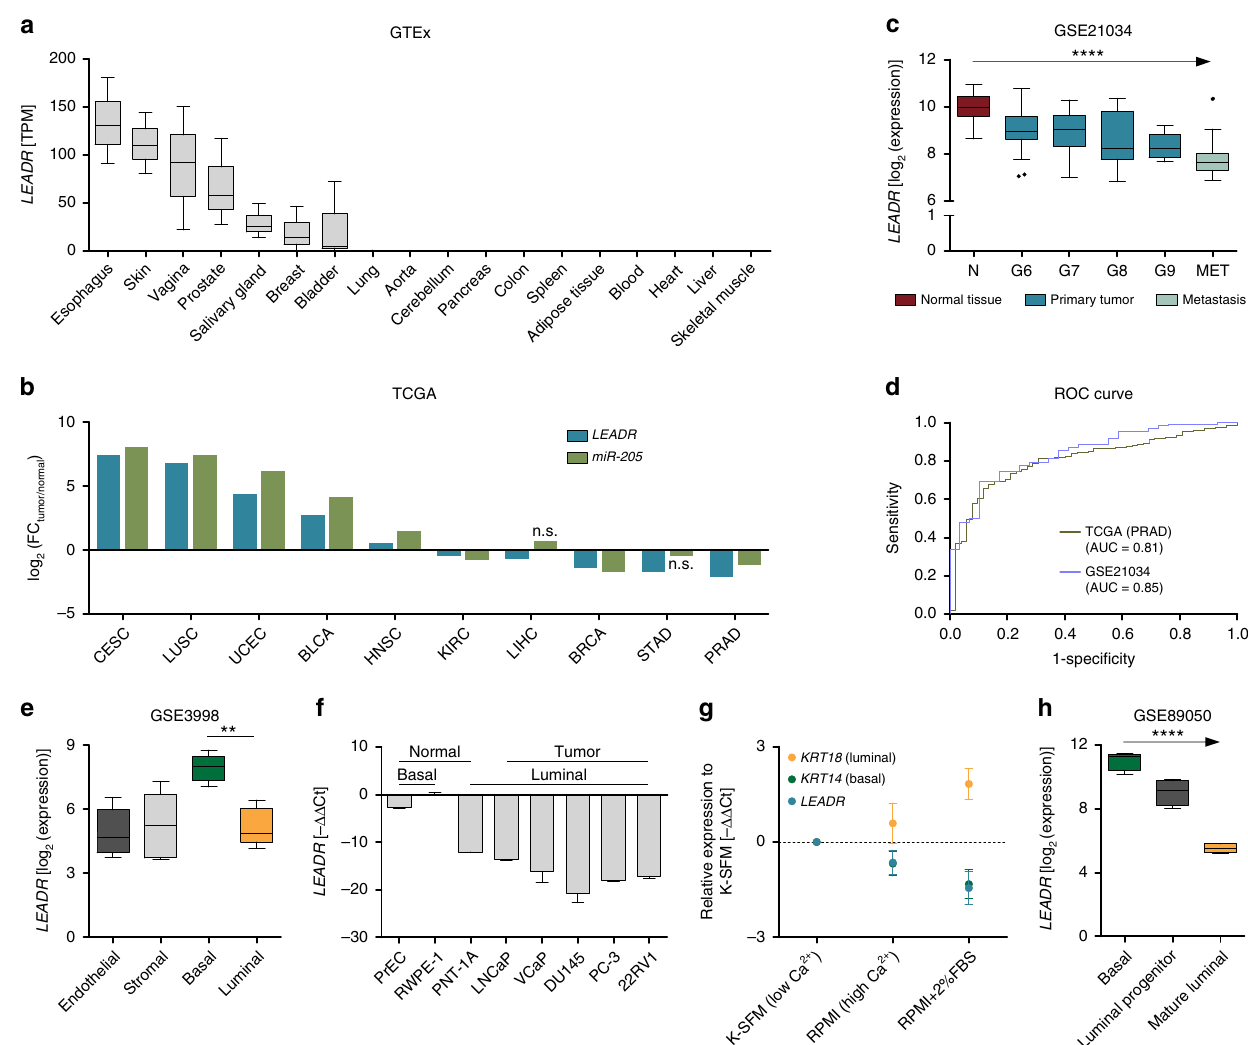
Fig. 1 LEADR/MIR205HG expression is enriched in prostate basal cells and reduced upon luminal differentiation. a Tukey ’ s box plot of LEADR/MIR205HG expression in human tissues as retrieved from GTEx data portal. b Bar plot of LEADR/MIR205HG and miR-205 fold-change (FC) in tumor vs. normal samples from TCGA. Only tumors where LEADR/MIR205HG is signi fi cantly differentially expressed compared to normal counterpart are shown (Student ’ s t test, p value threshold 0.05). Note that for all tumors where LEADR/MIR205HG is differentially expressed, also miR-205 is differentially expressed and in the same direction, except for LIHC and STAD, where the difference is not signi fi cant (n.s.). All tumor/normal pairs together with acronym meaning are reported in Supplementary Fig. 2a. c Tukey ’ s box plot of LEADR/MIR205HG expression in normal and tumor prostate samples from GSE21034 dataset. Jonckheere – Terpstra test evidences a signi fi cant decreasing trend along tumor progression. Samples are classi fi ed as normal (N), primary tumors (ranked based on Gleason pattern score grading system from G6 to G9), and metastatic (MET). d ROC curves of the performance of LEADR/MIR205HG in classifying tumor and normal tissues from two independent datasets (PRAD-TCGA and GSE21034). Area under the curve (AUC) is reported. e Tukey ’ s box plot of LEADR/MIR205HG expression in different cell subpopulations from human normal prostate (GSE3998, Student t test). f qRT-PCR reporting LEADR/ MIR205HG expression levels in different prostate cell lines (normal prostate total RNA used as reference). Mean + s.d. ( n = 3 qRT-PCR measurements for each cell line) plotted. g qRT-PCR showing progressive downregulation of LEADR/MIR205HG along basal – luminal differentiation induced in RWPE-1 cells by Ca 2 + (RPMI medium) ± serum (FBS). Mean ± s.d. ( n = 3) plotted. h Tukey ’ s box plot of LEADR/MIR205HG expression value in frankly basal, luminal progenitor (CD38 low ) and fully differentiated (CD38 high ) luminal cells sorted from human prostate (GSE89050). Jonckheere – Terpstra test evidences a signi fi cant decreasing trend along basal – luminal transition. ∗∗ p < 0.01; ∗∗∗∗ p < 0.0001. Source data are provided as a Source Data fi le, together with n of